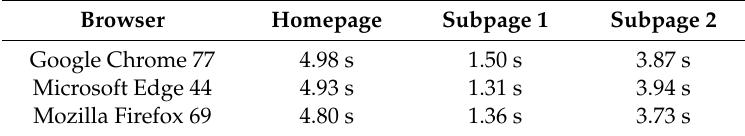
Table 2. Comparing 3D platform’s pages loading time on three major browsers.